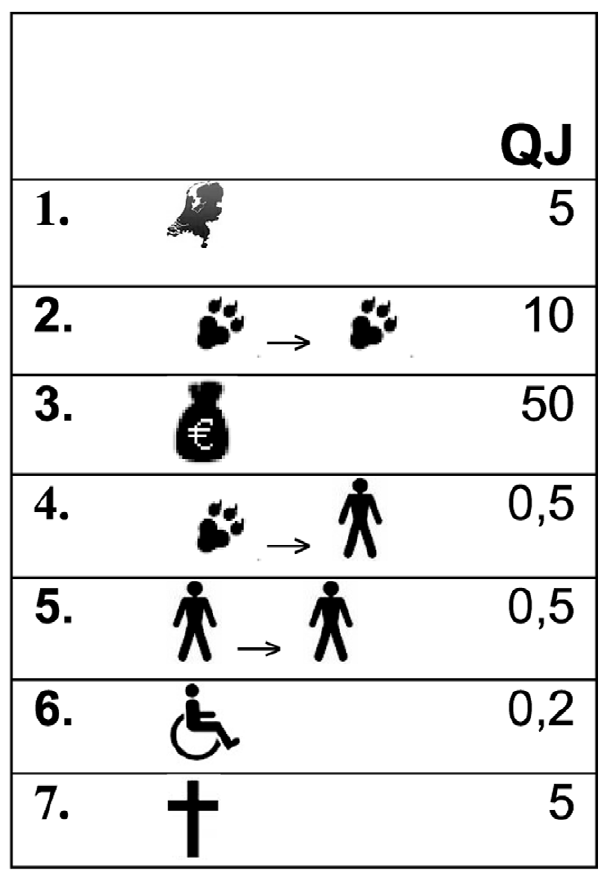
Figure 2. Example of card of a randomly generated scenario (QJ) used in the panel session to determine the relative weights of criteria. The numbers 1–7 represent the criteria C1–C7 (for details see Table